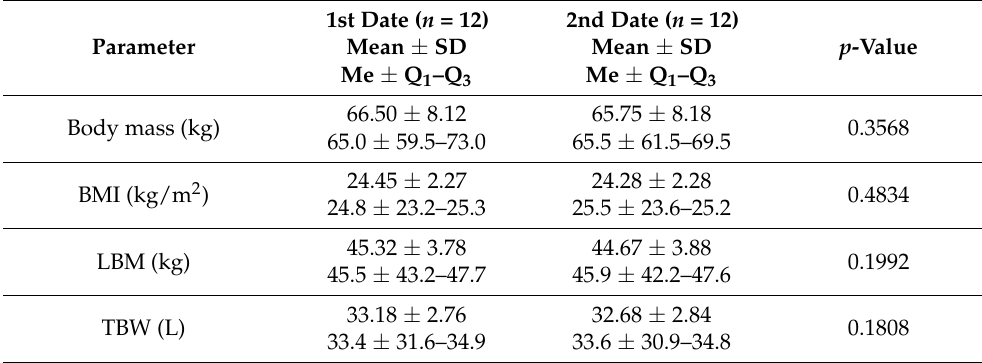
Table 1. Somatic and physical capacity parameters in sessions 1 and